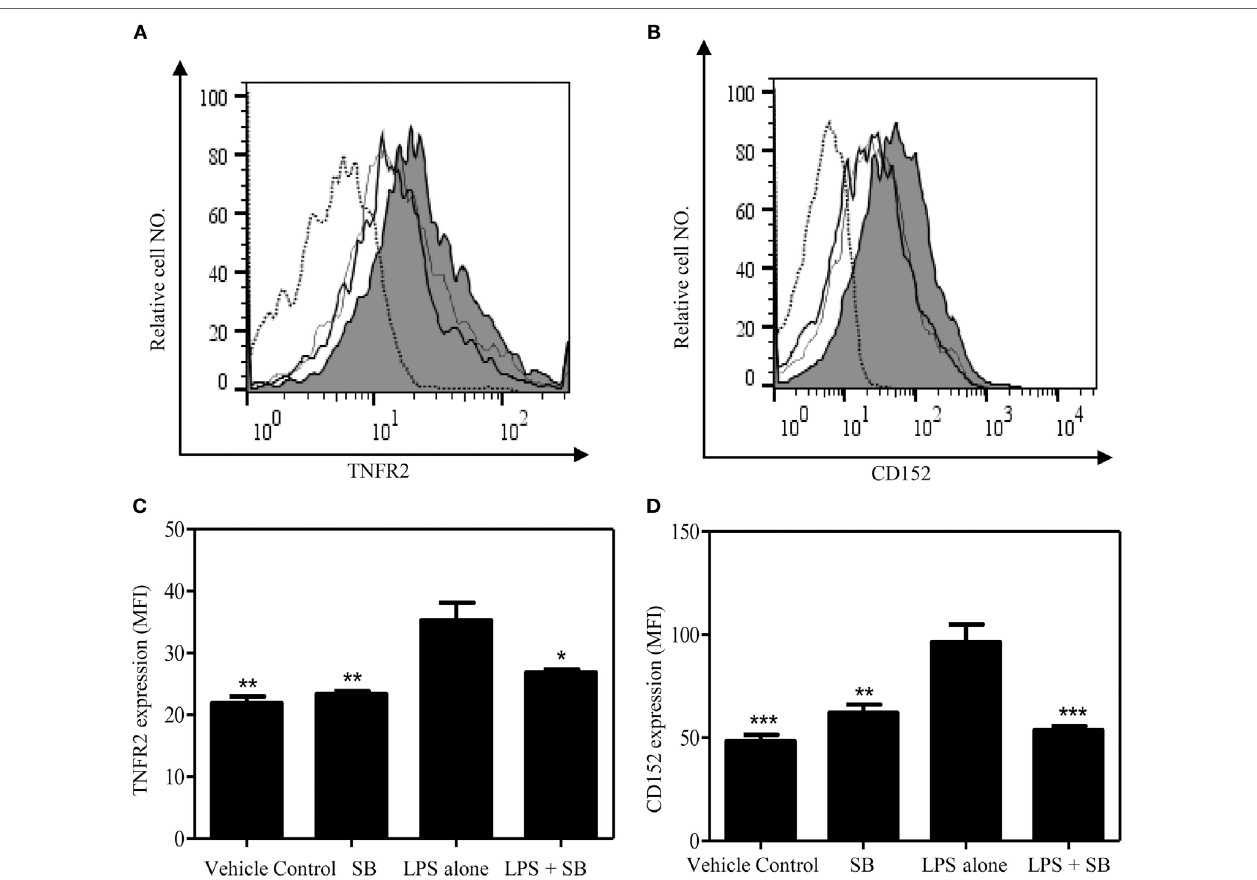
FigUre 6 | SB203580 inhibits the upregulation of TNFR2 expression and CD152 expression on regulatory T cells (Tregs) in LPS-treated mice. C57BL/6J mice were injected with 200 µg of LPS (i.p.) or PBS, and treated with or without SB203580 (25 mg/kg/day, i.p.). Mouse spleen were harvested at 24 h after injection for the FACS analysis of CD152 and TNFR2 expression, gating on Foxp3 + cells. (a,B) Typical FACS histograms were shown. Black solid line: vehicle control; gray-filled histogram: LPS treatment; hair line: LPS + SB203580; Dot histogram: isotype control. Summary TNFR2 expression [MFI. (c) ] and CD152 expression [MFI, (D) ] by Foxp3 + Tregs ( N = 3, means ± SEM). Data shown are representatives of at least three separate experiments with similar results. By comparison with LPS alone group, * p < 0.05, ** p < 0.01, *** p <